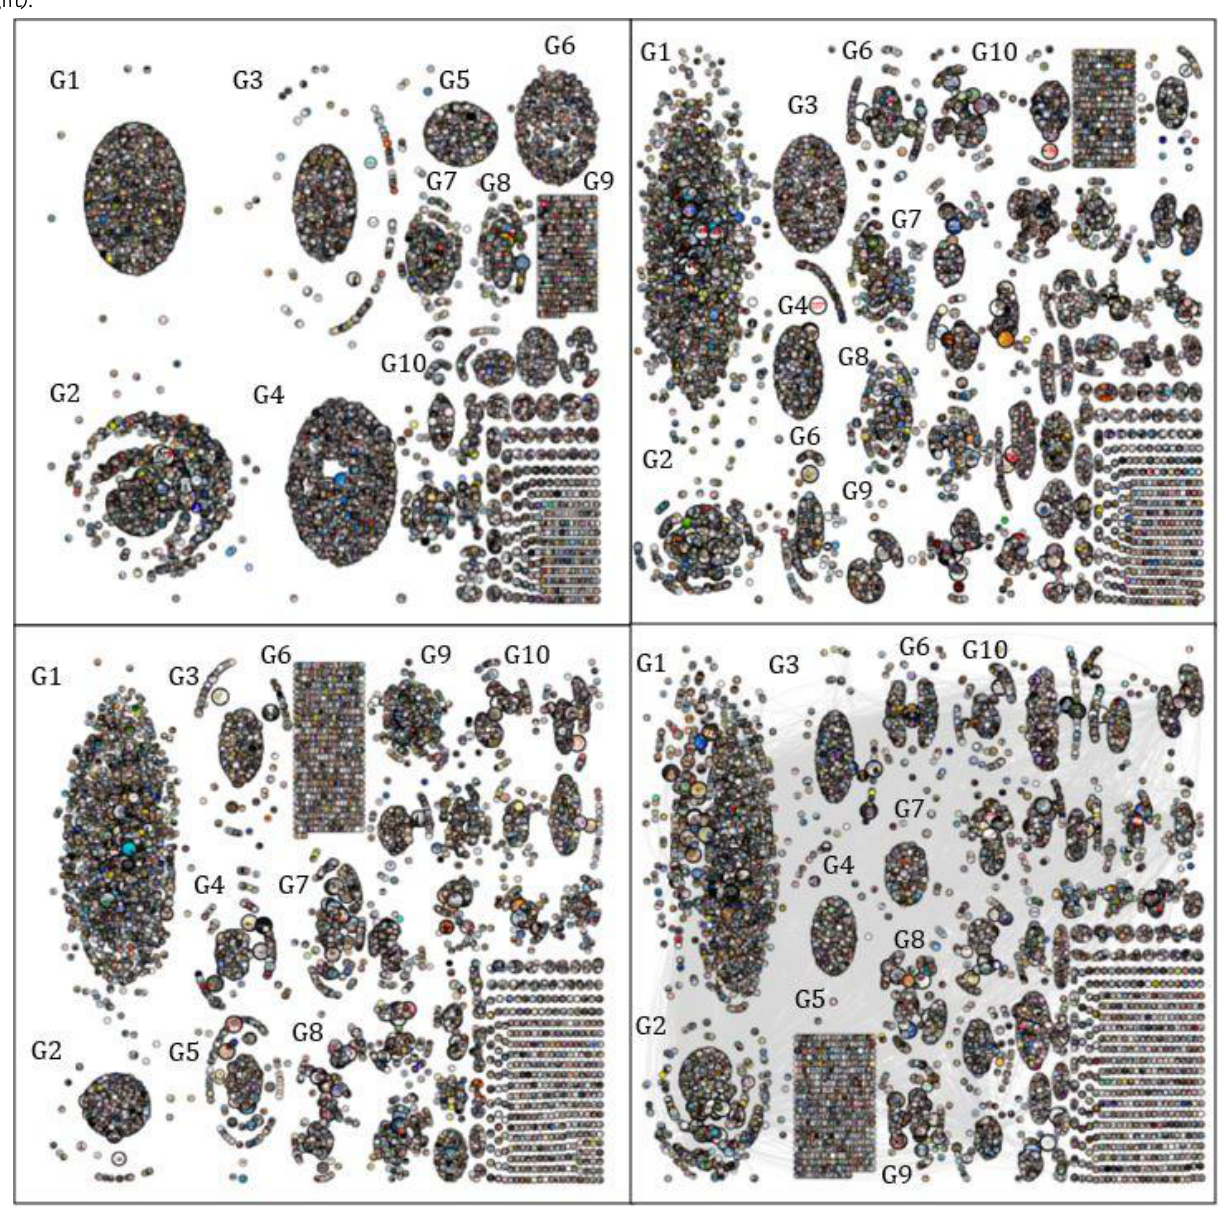
Figure 1. Korean coronavirus disease networks on Twitter. Coronavirus (top left), Corona19 (top right), Shincheonji (bottom left), and Daegu (bottom right).